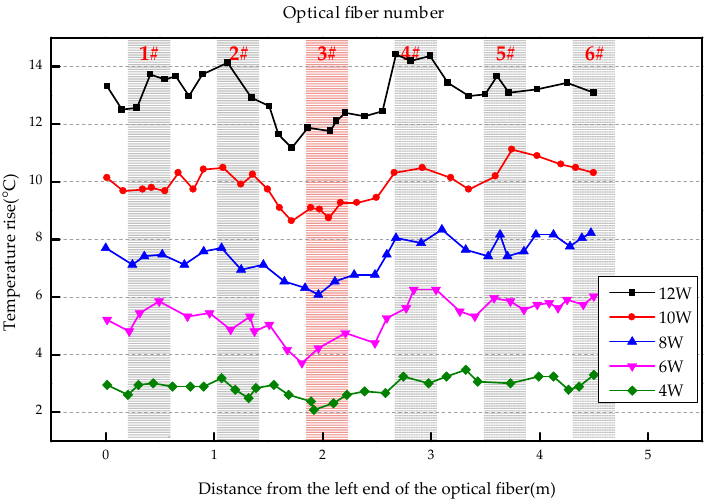
Sensors 2019 , 19 , x FOR PEER REVIEW Figure 8. Temperature increase curve of seepage flow velocity at 50 mm/h. Figure 8. Temperature increase curve of seepage flow velocity at 50 mm / h. Figure 8. Temperature increase curve of seepage flow velocity at 50 mm/h.